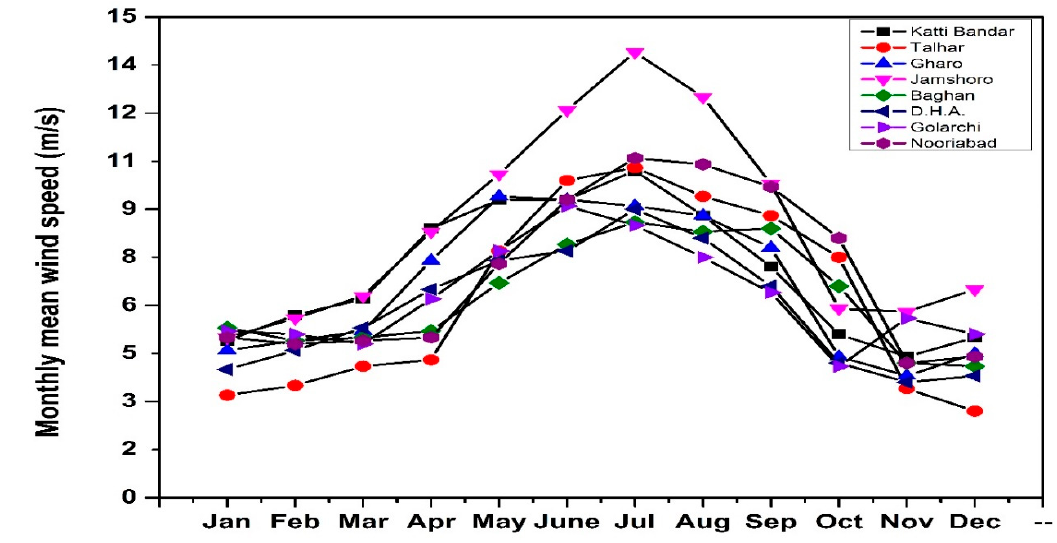
Figure 2. Monthly mean wind speed (m/s).